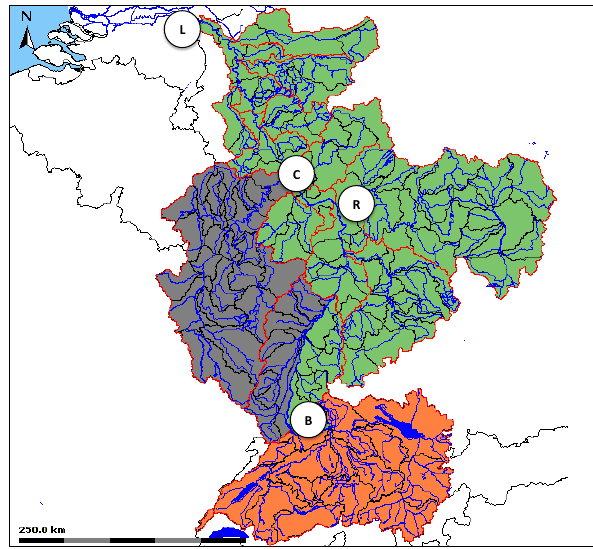
Fig. 1. The Rhine basin, the 134 sub-catchments and the three major sub-basins (Lower: upper right panel, Western: left panel, Upper: lower panel). The labels indicate the discharge observations pre- sented in the results section, L: Lobith, C: Cochem, R: Raunheim, B: